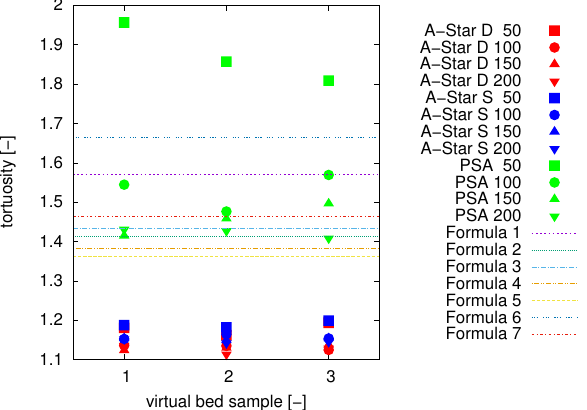
Figure 19. Comparison of tortuosity values (for chosen empirical